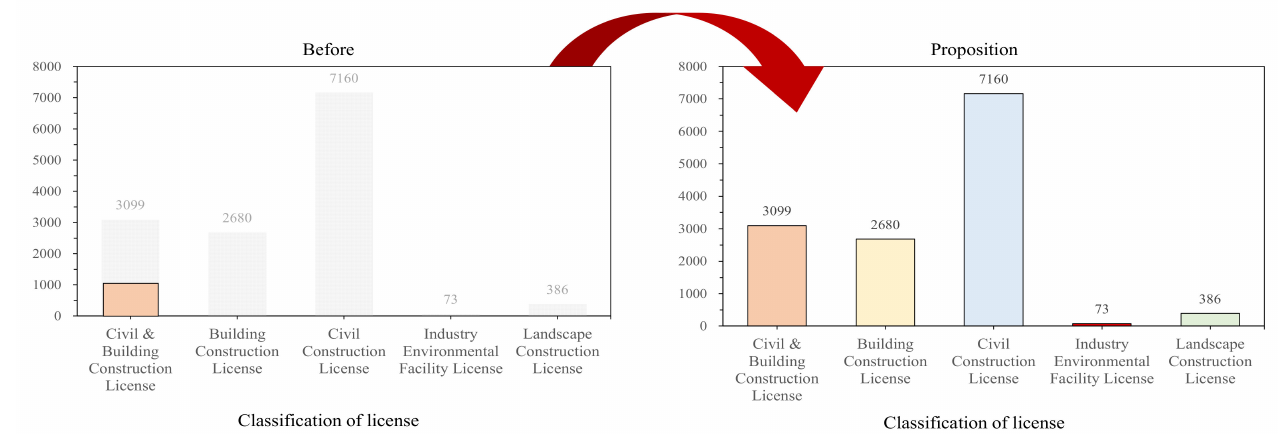
Figure 7. Expansion of system evaluation target qualifications (total number of construction companies: Construction Association of Korea, 2020).